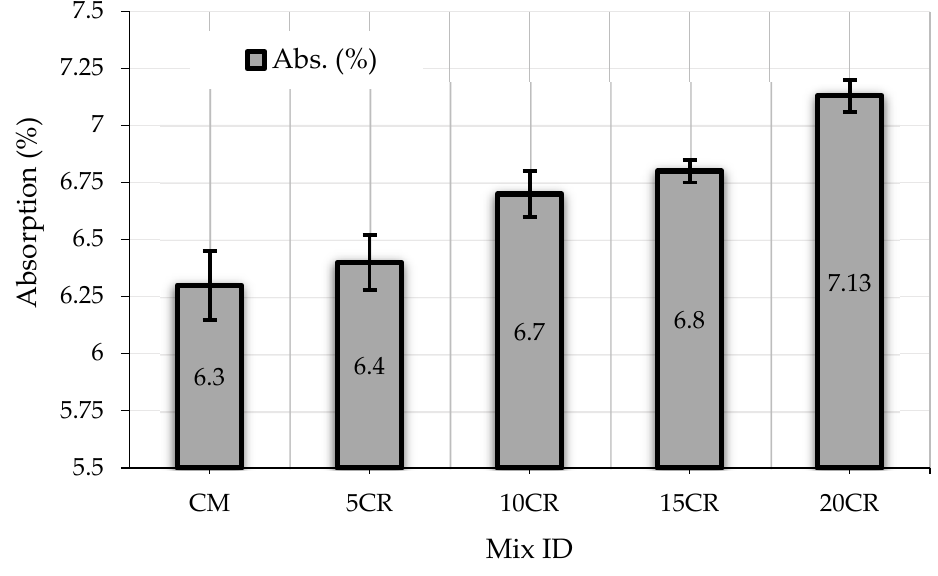
Figure 7. Absorption of different mixes.